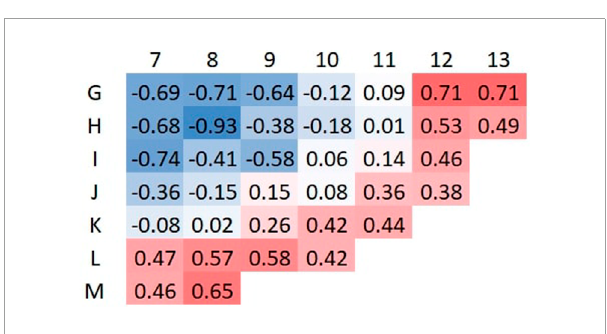
FIGURE 7 Relative difference in power distribution per fuel assembly between ENDF/B-VII.0 and ENDF/B-VIII.0 in